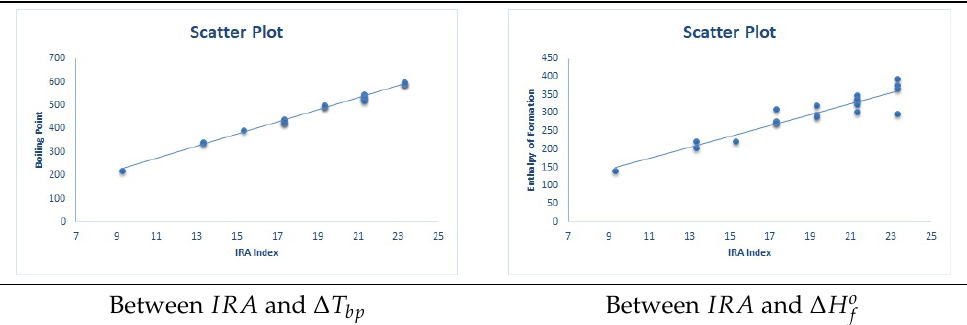
Table 5. Scatter plots between the IRA index and the two selected properties, i.e., ∆ T bp and ∆ H o